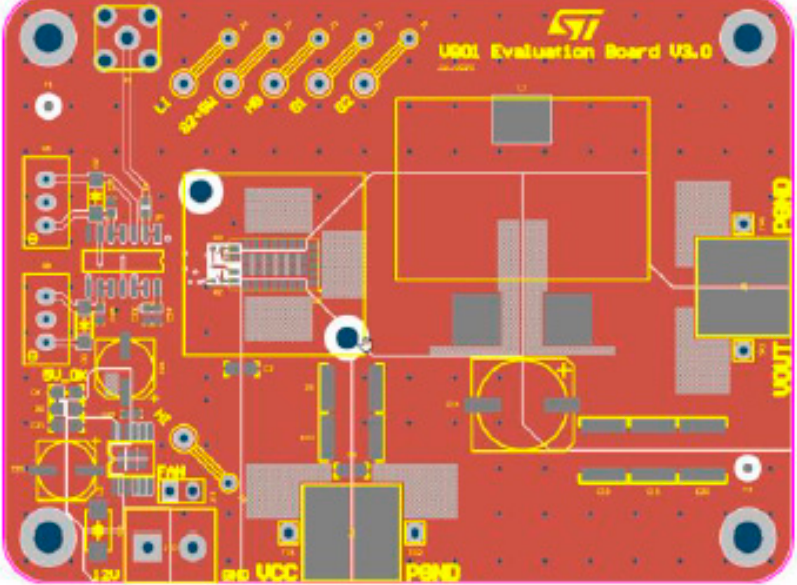
Figure 5. Top layer of the single-phase buck converter demo board.